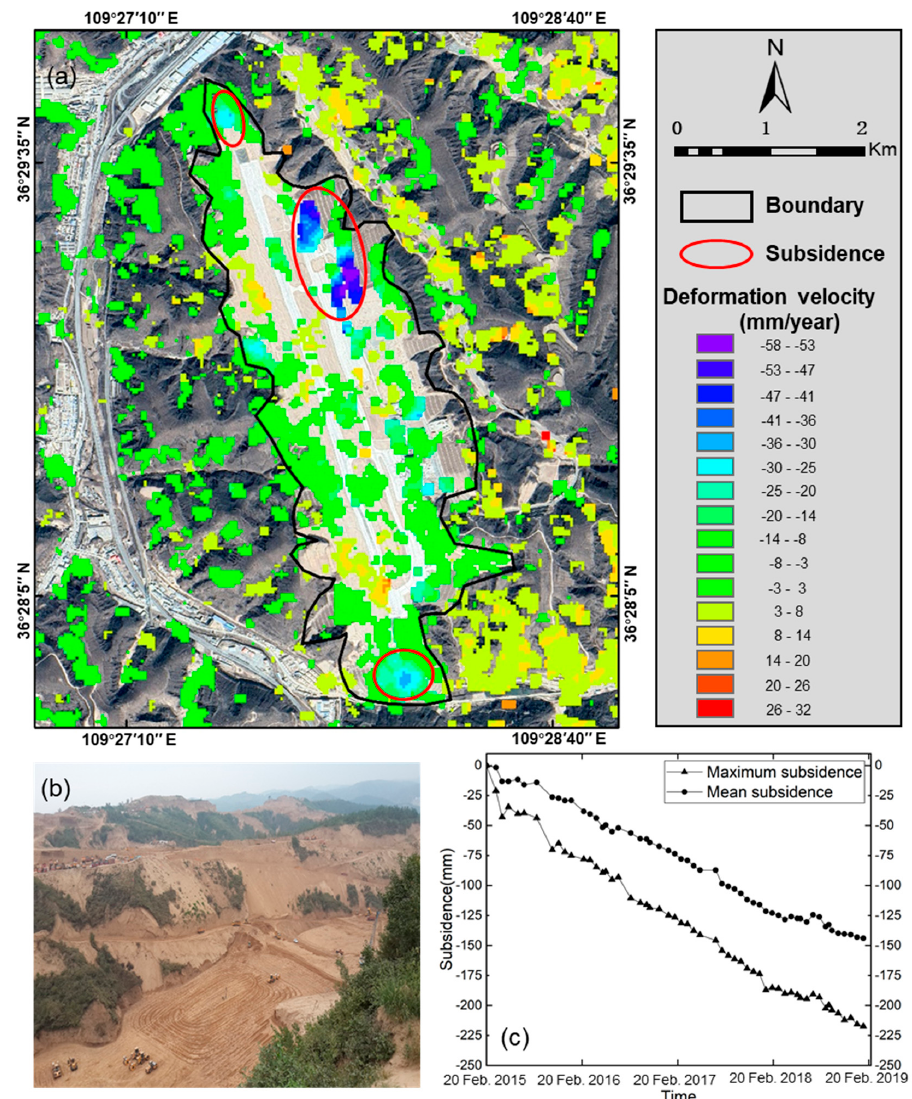
Figure 9. ( a ) Average rate of surface deformation in Yan’an new airport (YNA) superimposed on the Google Earth image, ( b ) the earthwork scene in YNA, and ( c ) the maximum and average accumulated subsidence of the largest red circle in (a).